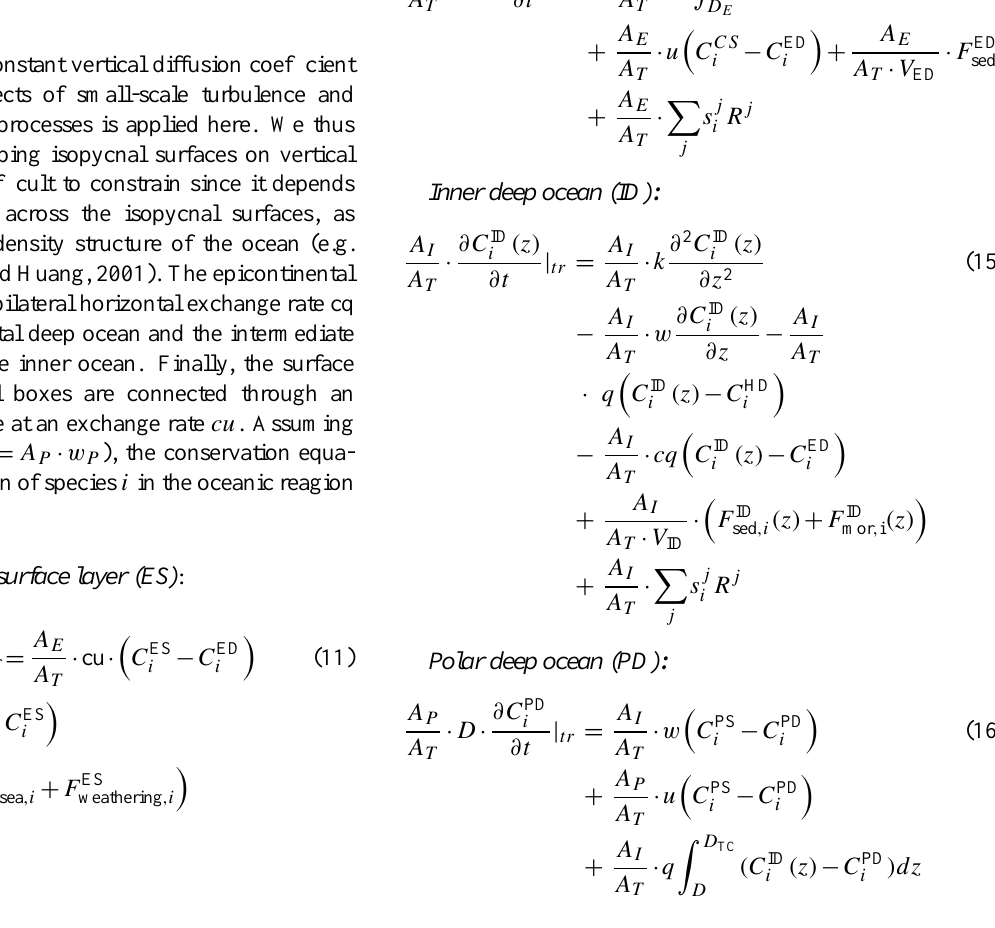
Fig. 2. Schematic presentation of the ocean diffusion-advection box model. The global ocean is divided into a two layer (surface, deep) epicontinental ocean (ES, ED) of depth D E and surface area A C , a vertically-resolved stratified inner ocean (IS, ID) of depth D and surface area A I and a two layer well-mixed polar ocean (PS, PD) of depth D and surface area A P . The parameterization of the global ocean circulation is discussed in the text and the ocean’s geometry is provided in Table 3.